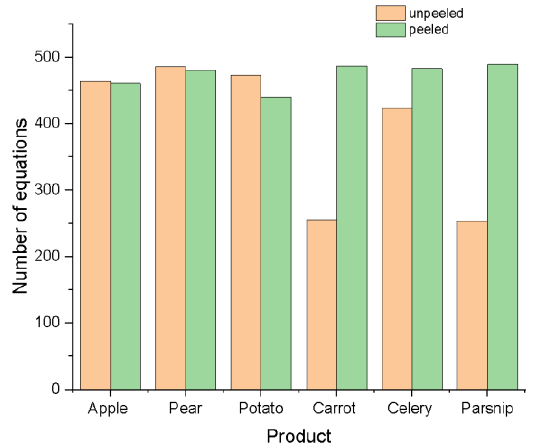
Figure 12. The number of equations generated by Table Curve 3d software varies according to the type of product under research.